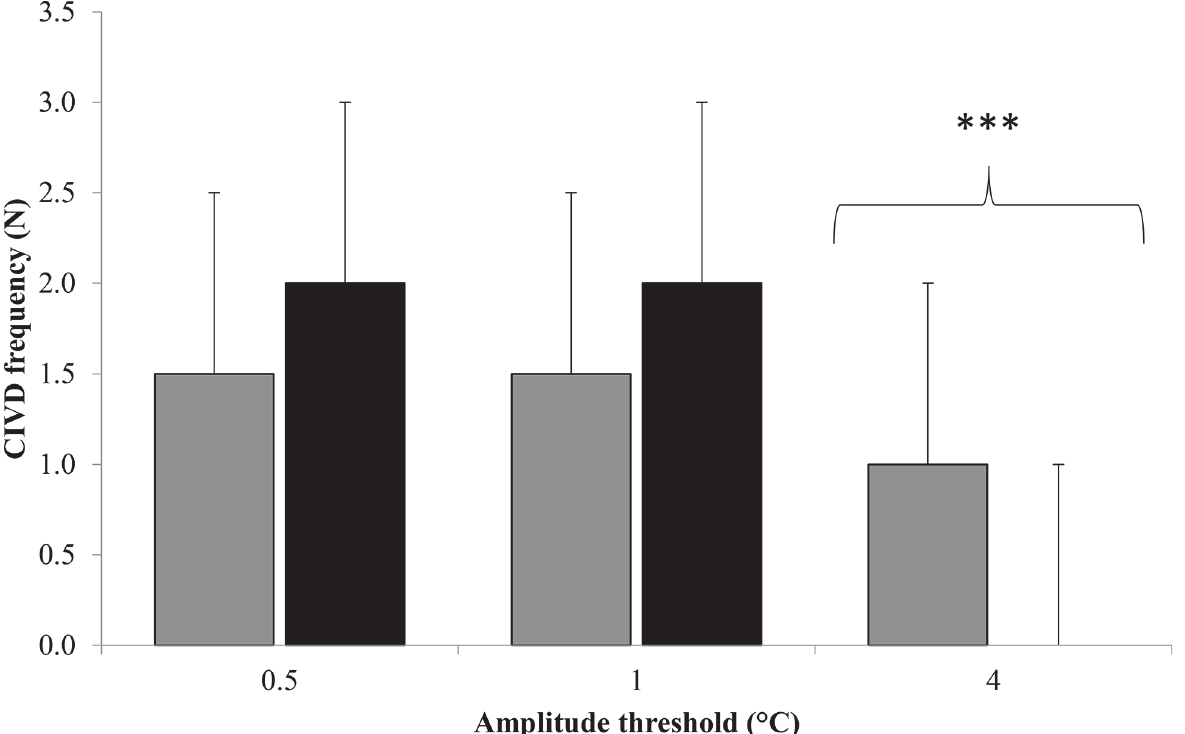
Fig 2. Median (range) frequency (N) when using amplitude thresholds of 0.5, 1 and 4°C. Grey fill = 0°C trial; Black fill = 8°C; *** = significantly lower than 0.5°C and 1°C (p < 0.001).